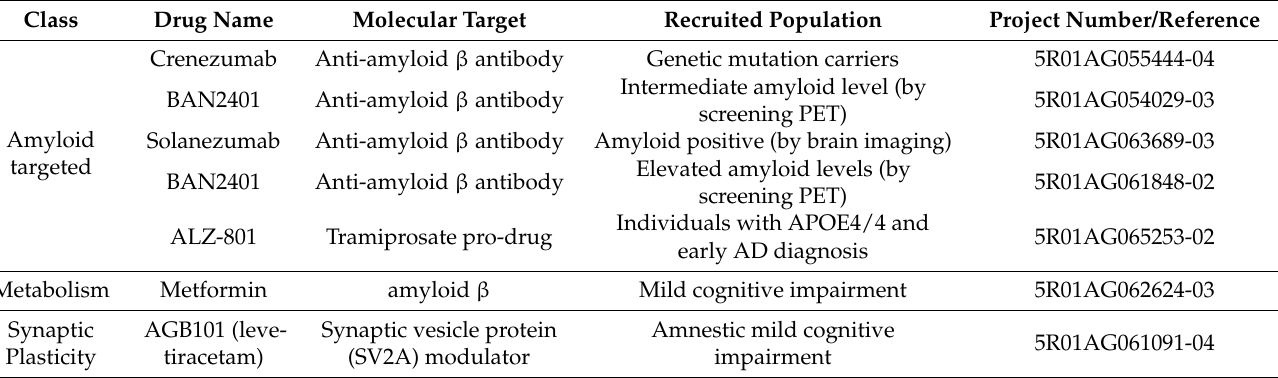
Table 1. Late-stage clinical drug development (phase II/III, III, and IV